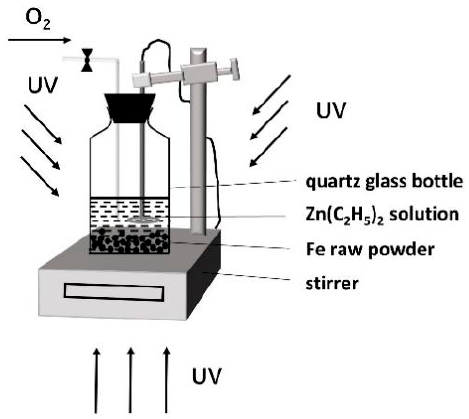
Figure 1. Schematic diagram of iron powders coated with ZnO by photodecomposition. The preparation process of the Fe-based soft magnetic composites was as follows. Zinc stearate (0.5 wt.%) acted as the lubricant and was mixed with the as-dried powders in the agate mortar. Then, the fully mixed powders were compacted at 1000 MPa into a ring with an outer diameter of 12.7 mm and an inner diameter of 7.5 mm. Finally, the rings were annealed at 773 K for 3 h under Ar atmosphere